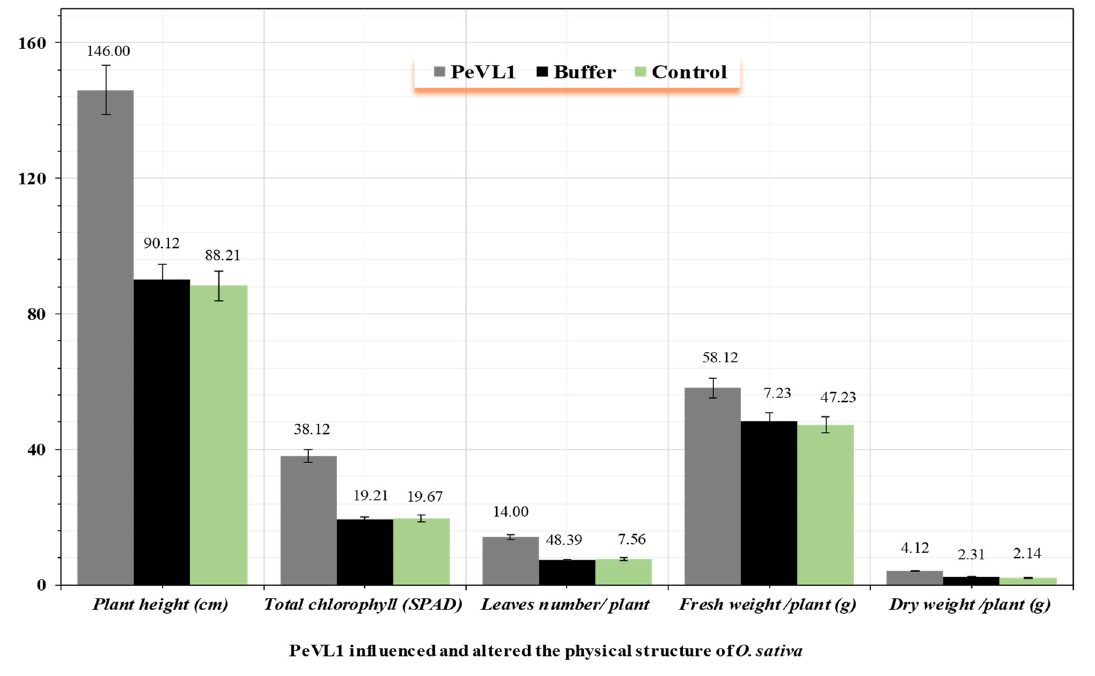
Figure 5. The effect of PeVL1 on the growth of treated and untreated seedlings. ( n = 10) PeVL1 and buffer seedling (mean ±SD). The data were compared with LSD and one-way ANOVA with Levene’s test ( p = 0.05) in SPSS 18.0.